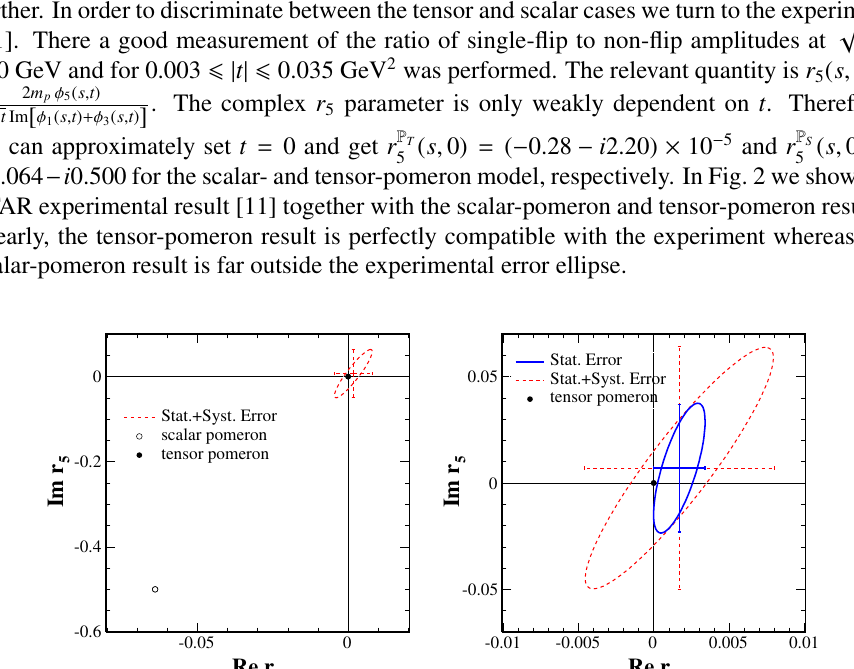
Figure 2. The experimental results for r 5 at for the tensor and the scalar pomeron from